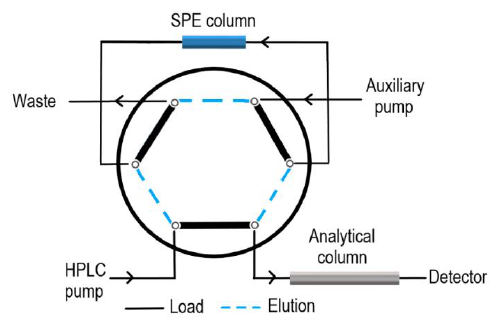
Figure 1. Schematic set up for on-line solid-phase extraction in a back-flush mode.